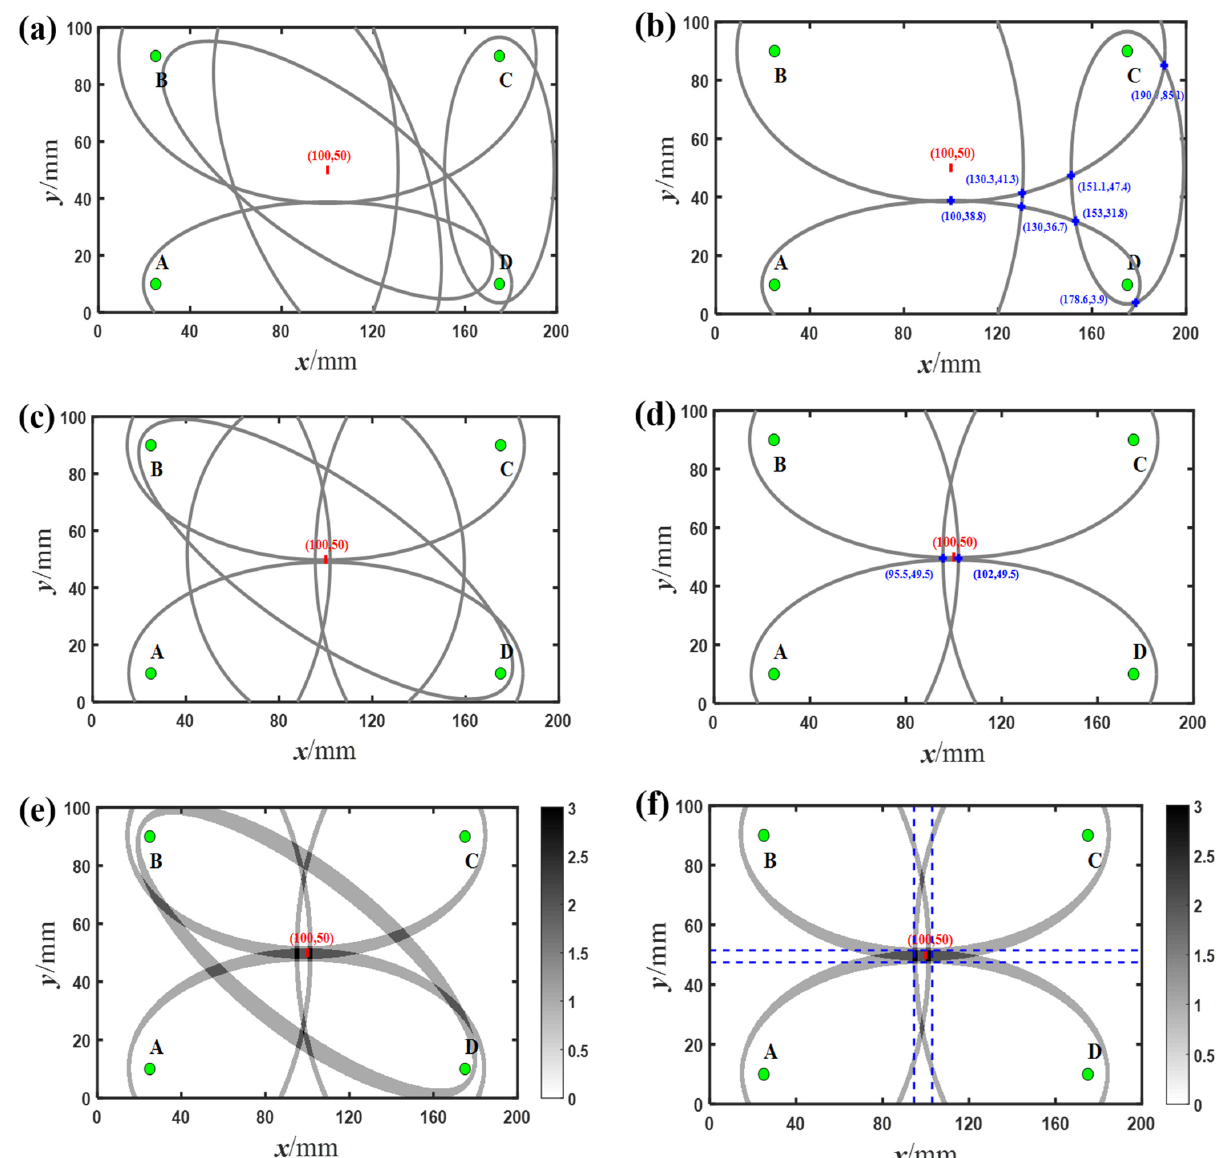
Figure 8. Experimental localization and imaging of a small crack (( a ) red line) with ellipse method using linear Lamb waves ( a , b ) and nonlinear Lamb waves ( c , d ), and with modified ellipse method using nonlinear Lamb waves ( e , f ). ( a , c , e ): signals received from all sensing paths were taken. ( b , d , f ): signals received from all sensing paths but AC and BD were taken.